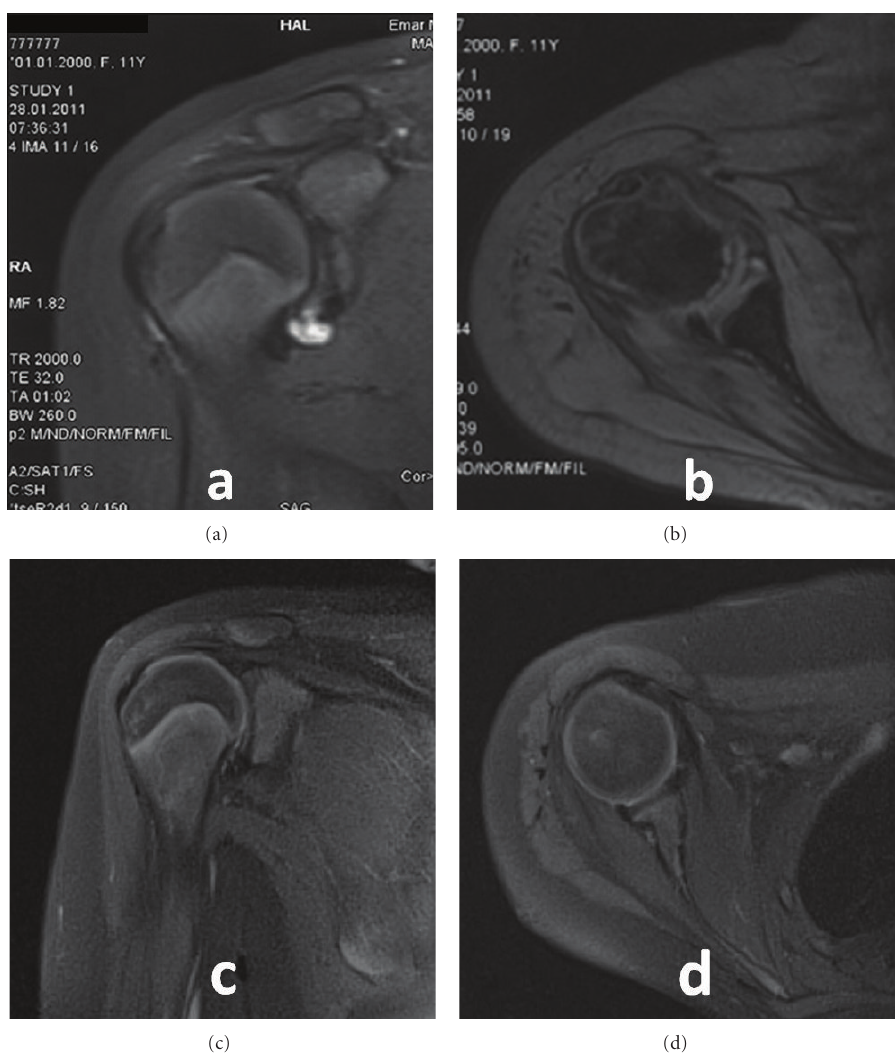
Figure 1: Preoperativecoronal (a) and axial (b) MRI views of capsulolabral separation. Postoperative one-year coronal (c) and axial (d) MRI views of capsulolabral repair.